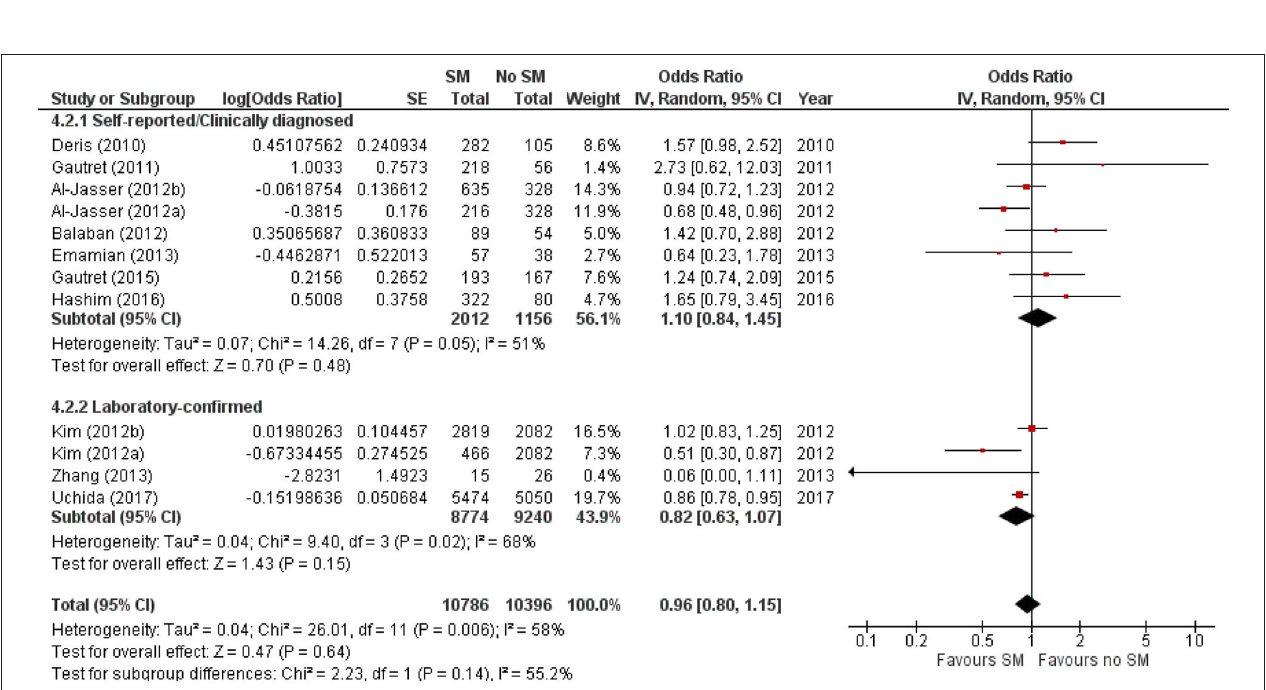
Frontiers in Medicine |